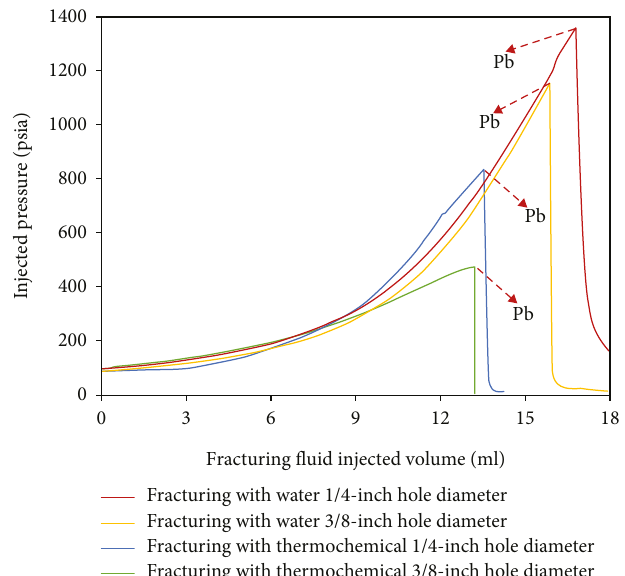
Figure 15: Injection pro fi le comparison of the three cases studied.